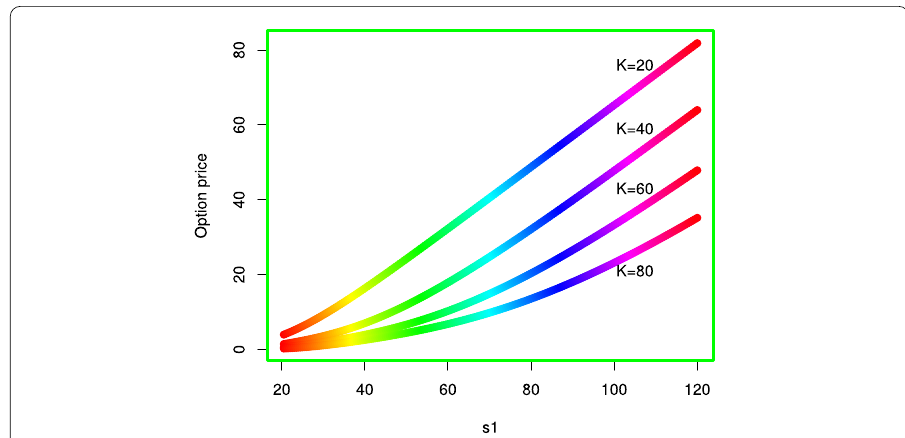
Figure 2 Vulnerable call option of different values of K and s